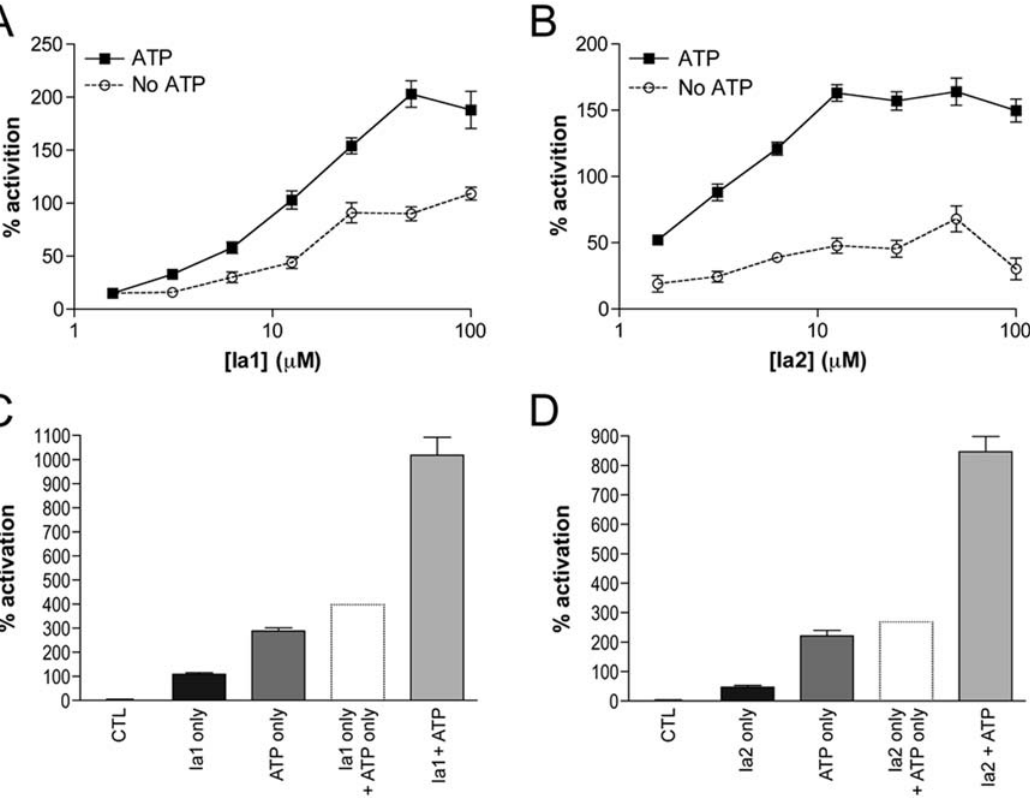
Figure 4. Synergistic effects of ATP and Ia1 or Ia2. A , B , Activating effects of Ia1 ( A ) and Ia2 ( B ) on IDE-mediated hydrolysis of SP1 when tested in the absence or presence of ATP (0.1 mM). Data have been normalized to controls containing DMSO only or DMSO plus ATP, respectively. C , D , Pronounced synergy between ATP and Ia1 (50 m M; C ) and Ia2 (10 m M; D ). In this case, data are presented as raw activation values, all normalized to DMSO-only controls lacking ATP. Dashed columns show the predicted magnitude of activation if the effects of ATP and Ia1 or Ia2 were simply additive. Data are mean 6 SEM for 4 independent experiments. For panels A and B , data showing $ 30% activation are statistically different from corresponding controls ( P , 0.05). For panels C and D , data are statistically different for all comparisons ( P ,